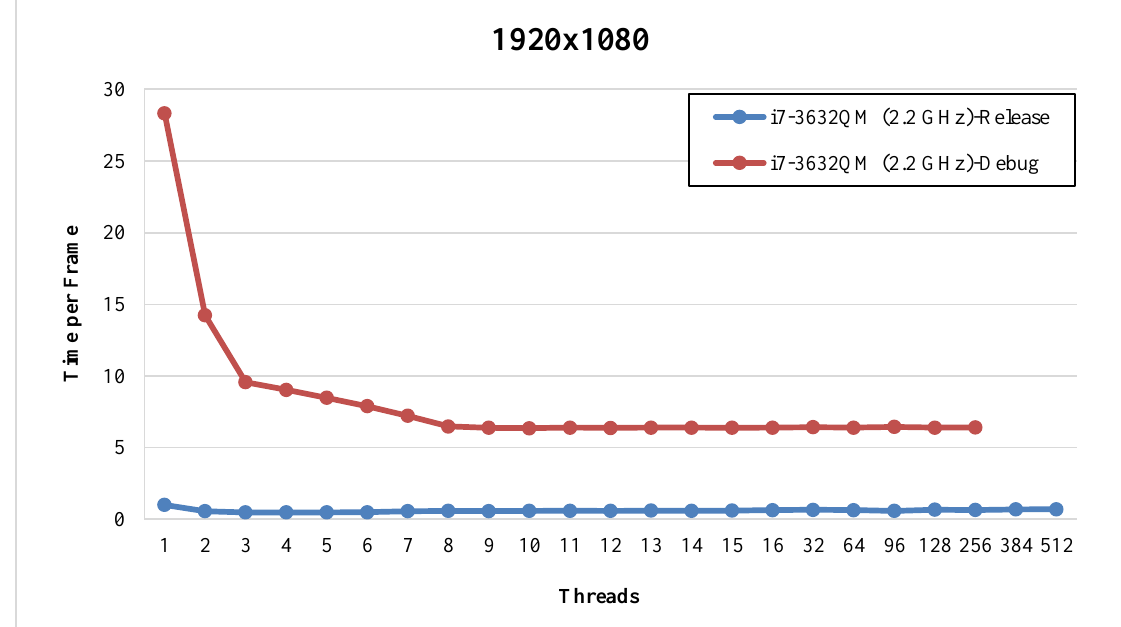
Figure 6. Compare the behavior of the application in Debug and Release modes to generate an image in 1080p resulation by different threads